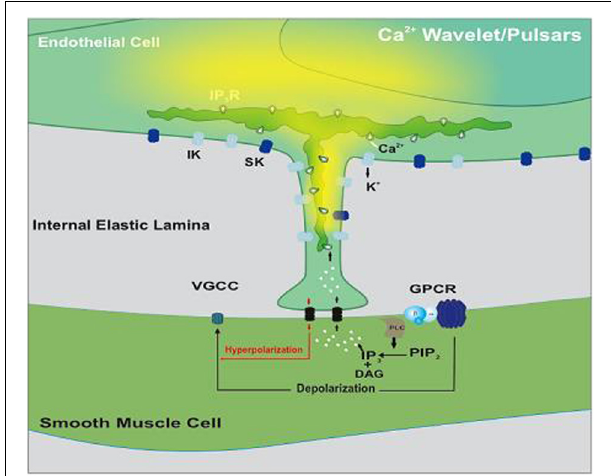
FIGURE 1 | Illustrative diagram of the myoendothelial feedback pathway. Smooth muscle agonists activate G protein-coupled receptors (GPCR) initiating IP 3 production via phospholipase C (PLC). This second messenger crosses myoendothelial gap junctions and triggers Ca 2 + release via IP 3 Rs positioned on the endoplasmic reticulum. As Ca 2 + wavelets/ pulsars spread, they activate intermediate-conductance Ca 2 + -activated K + (IK) channels within or near the endothelial projection. The resulting hyperpolarization conducts back to smooth muscle where it sequentially attenuates depolarization, Ca 2 + influx through voltage-gated Ca 2 + (VGCC) and arterial constriction. Modified from Tran et al.